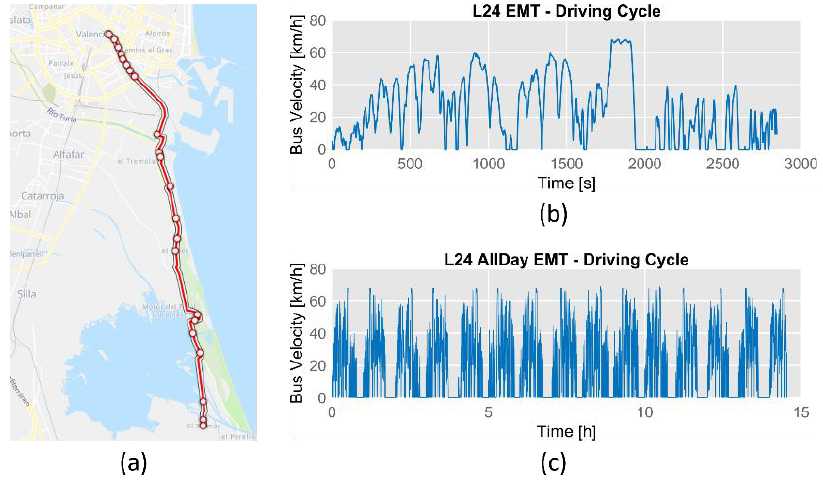
Figure 17. Route 24 (EMT Valencia): ( a ) route, ( b ) one-way driving cycle, ( c ) all-day driving cycle.